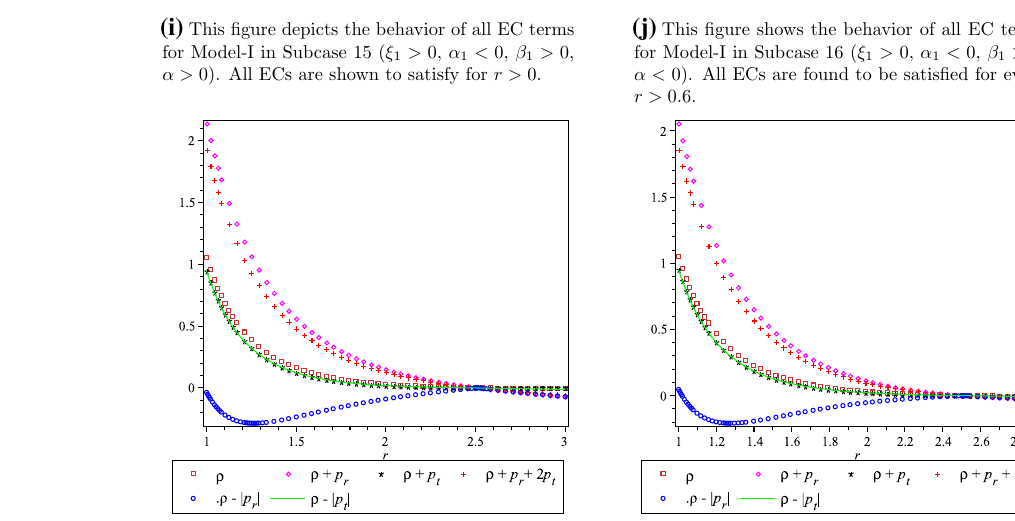
for Model-I in Subcase 18 ( ξ 1 < 0, α 1 > 0, β 1 > 0, α < 0). All ECs are found to be satisfied for every r > 2 .